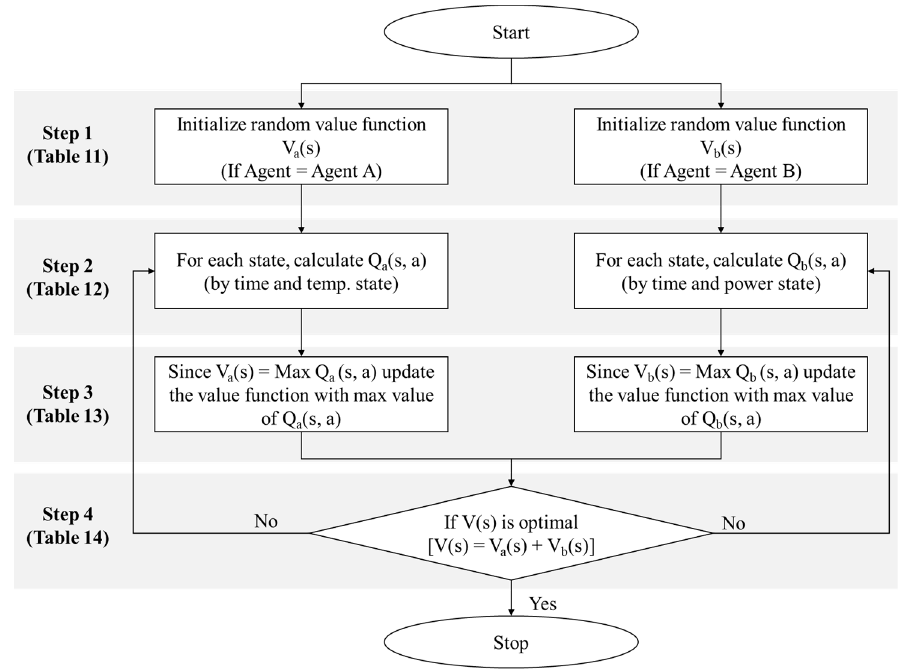
Figure 12. Value iteration algorithm with the Bellman equation for RL-based BEMS optimization by